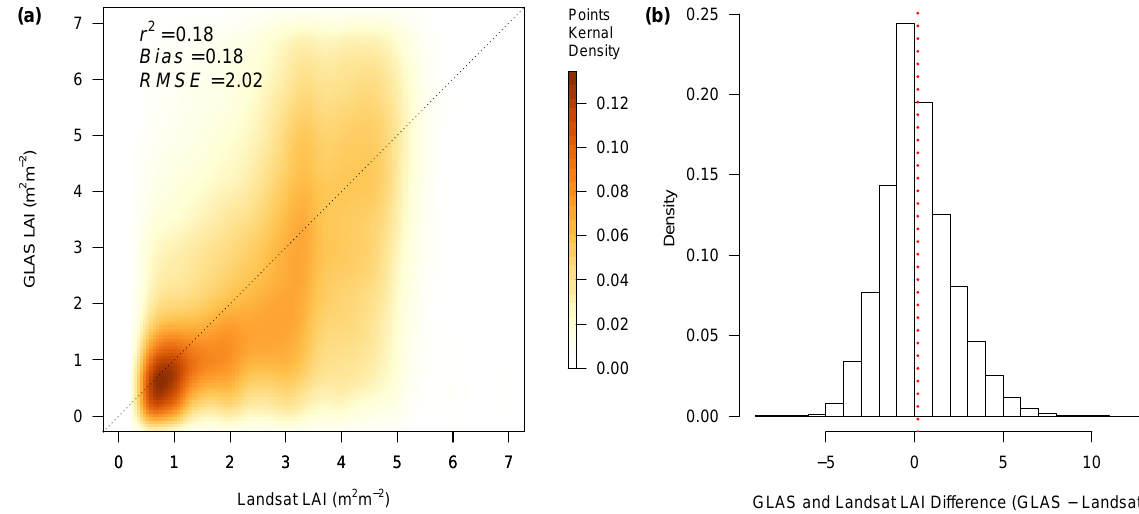
Figure 4. Comparison between Landsat LAI and GLAS LAI over the contiguous US: (a) density scatter plot of Landsat and GLAS LAI ( r 2 = 0.18, bias = 0.18 and RMSE = 2.02); (b) difference between Landsat and GLAS LAI. Darker kernel density color refers to a more clustered distribution of LAI